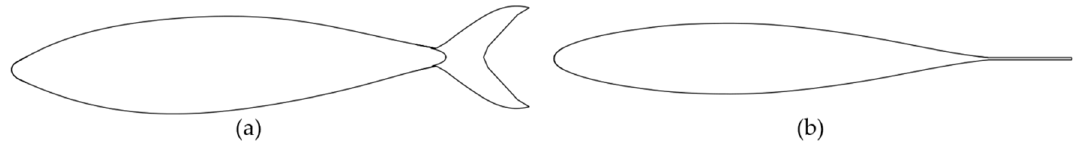
Figure 3. Sketches of the Atlantic mackerel modeled in this work: ( a ) side and ( b ) upper views [15].